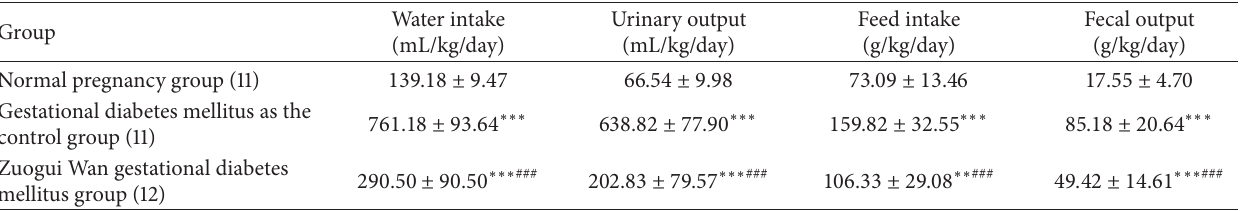
Table 2: Impact of Zuogui Wan on metabolism cage index in rats of gestational diabetes